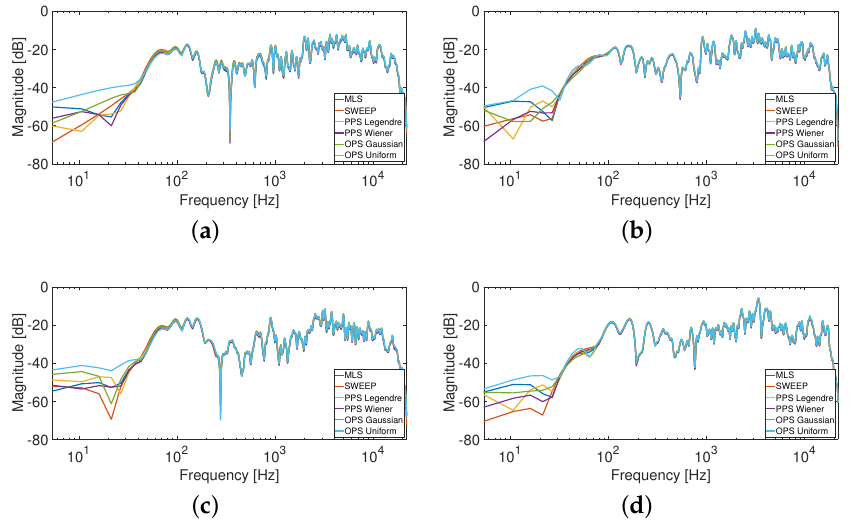
Figure 4. HRTF measurements with the mannequin in the passenger position; in particular, ( a ) is the response of the left ear and the left speakers, ( b ) is the response of the left ear and the right speakers, ( c ) is the response of the right ear and the left speakers and ( d ) is the response of the right ear and the right speakers. A smoothing of 1/12 octave band was applied to the